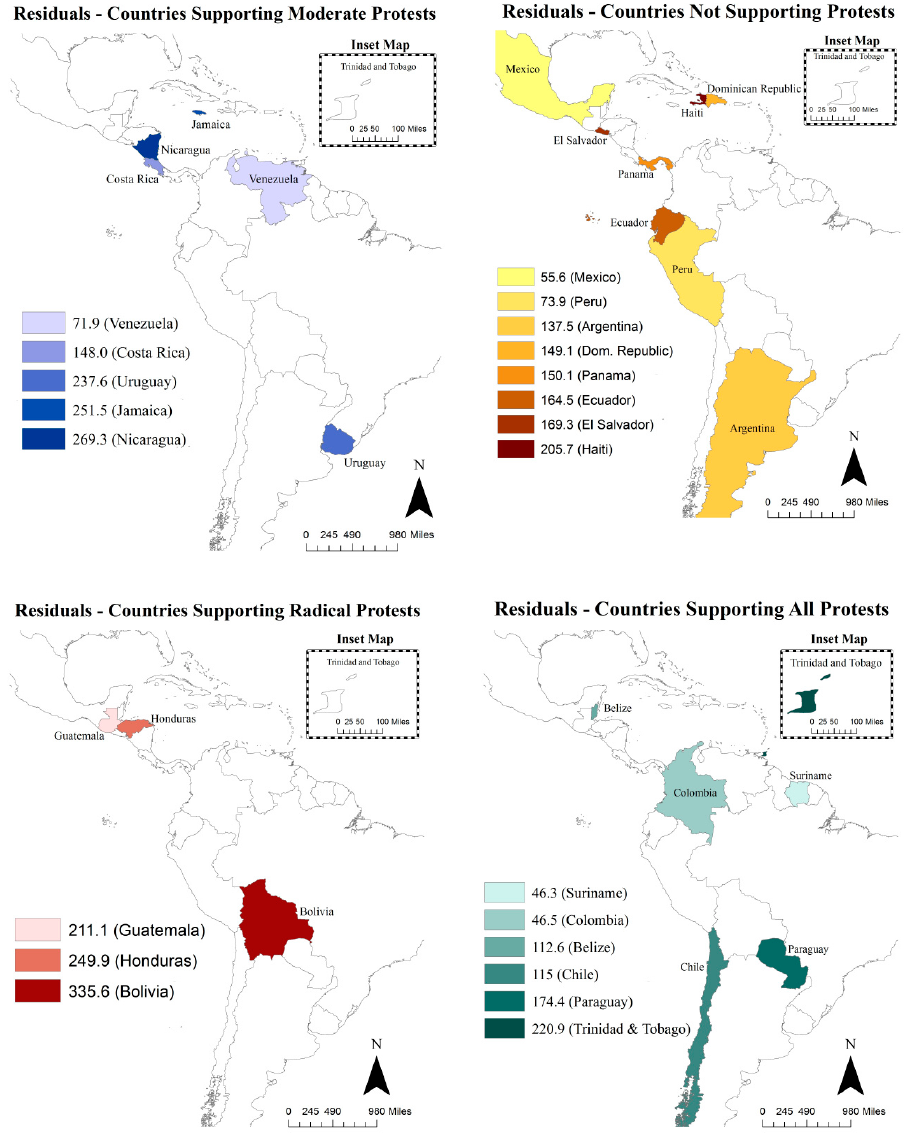
Figure 1. Different attitudinal groups for support for protests.